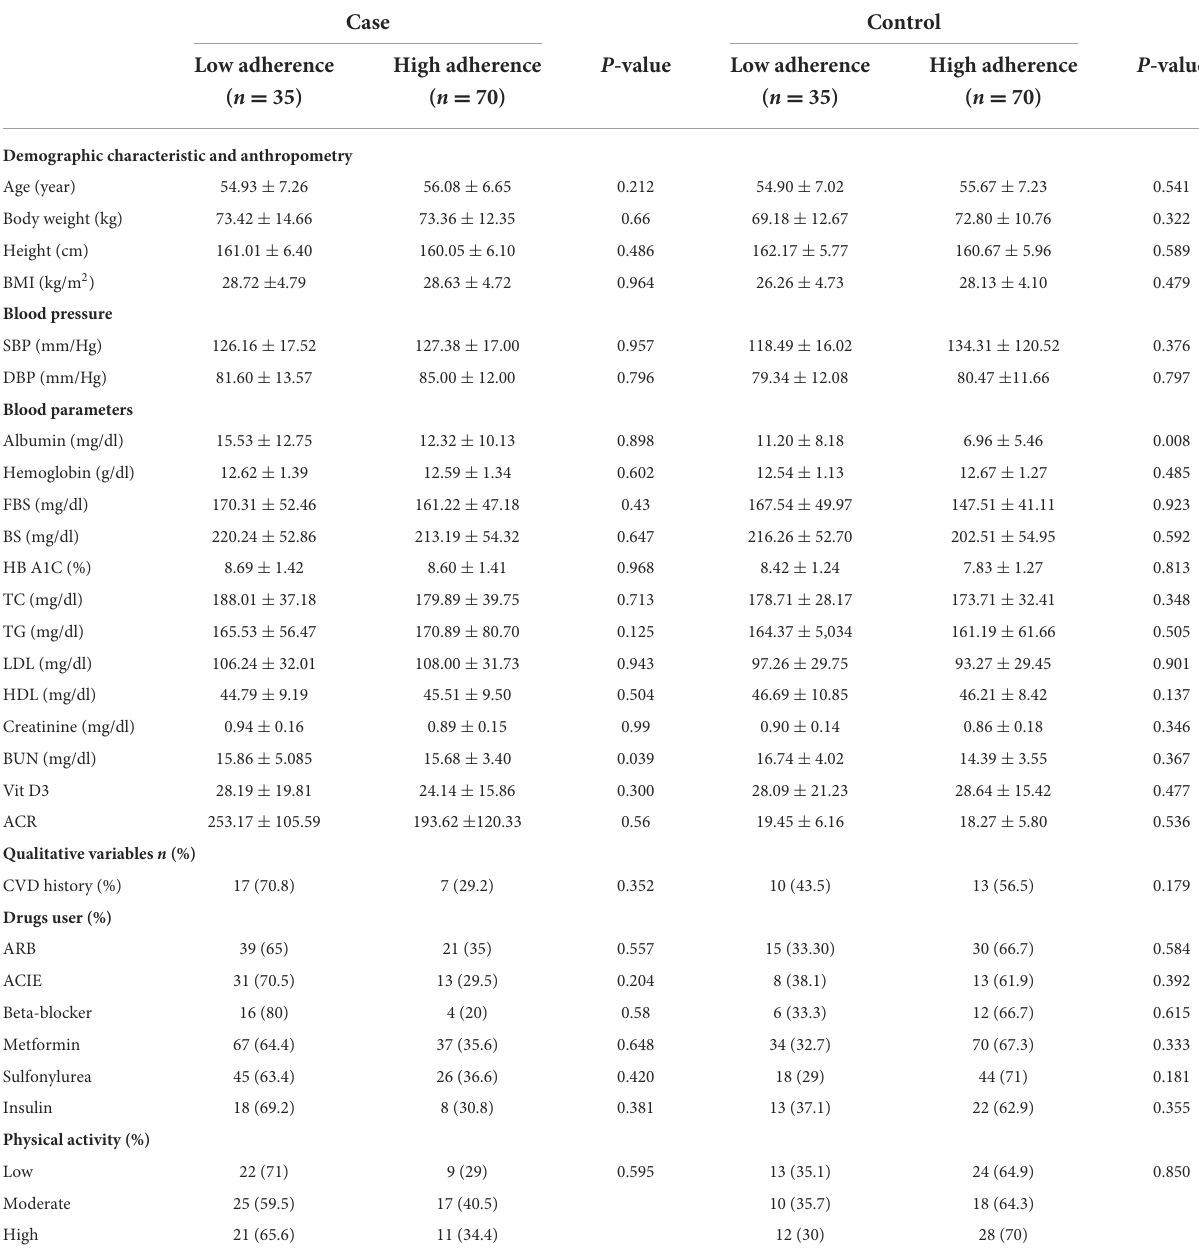
Mediterranean diet